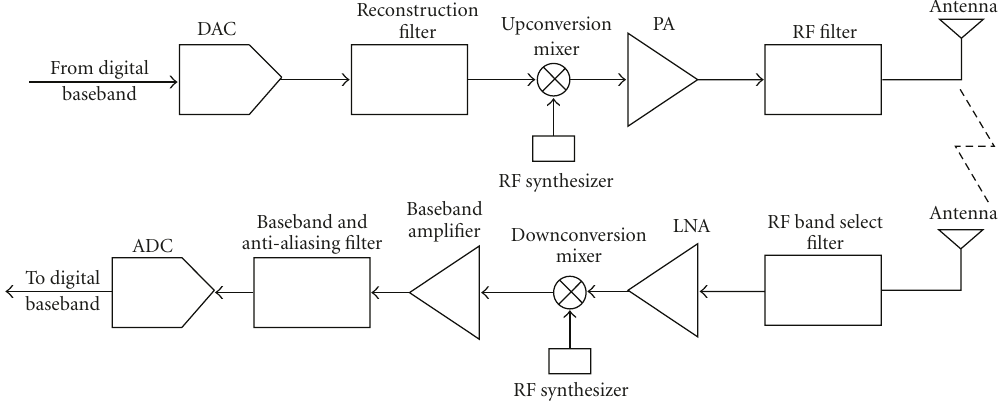
Figure 1: Block diagram of the transceiver analog signal